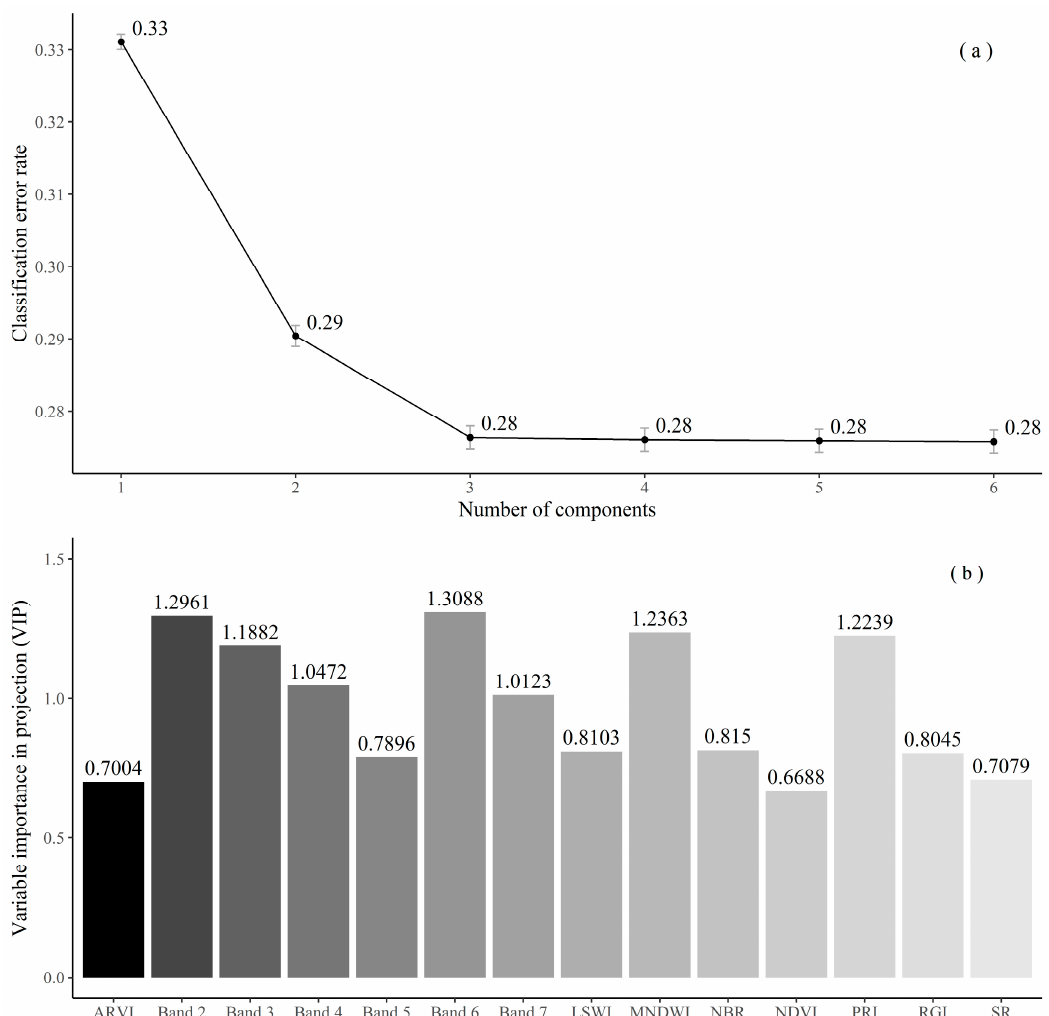
Figure 2. Cross-validation error rate and number of principal components for the calibration model ( a ) and Variable importance in projection (VIP) of bands and vegetation indexes calculated from Landsat-8 OLI satellite band reflectance ( b ) to characterize the model components.